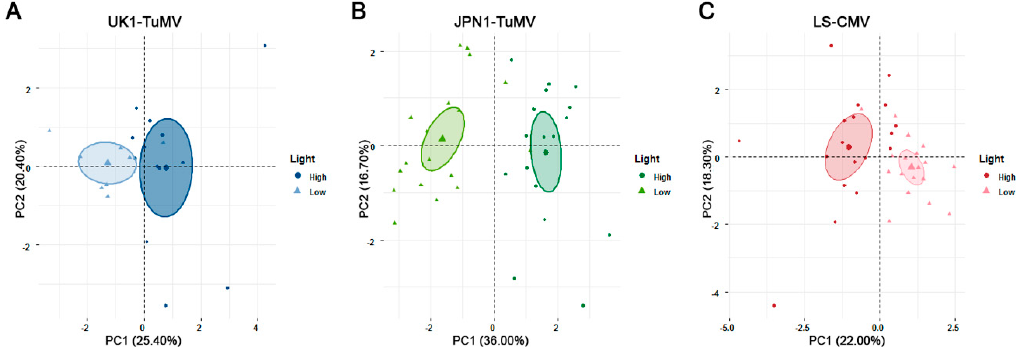
Figure 4. Principal component analysis of data for the e ff ect of UK1-TuMV ( A ), JPN1-TuMV ( B ) and LS-CMV ( C ) infection on the plant developmental schedule, growth and reproduction traits, virus accumulation, fecundity and mortality tolerance and virus seed transmission from 18 accessions of Arabidopsis grown under high (circle) and low (triangle) light conditions. Colored ellipses represent 95% confidence intervals around the mean (bold point) for each light